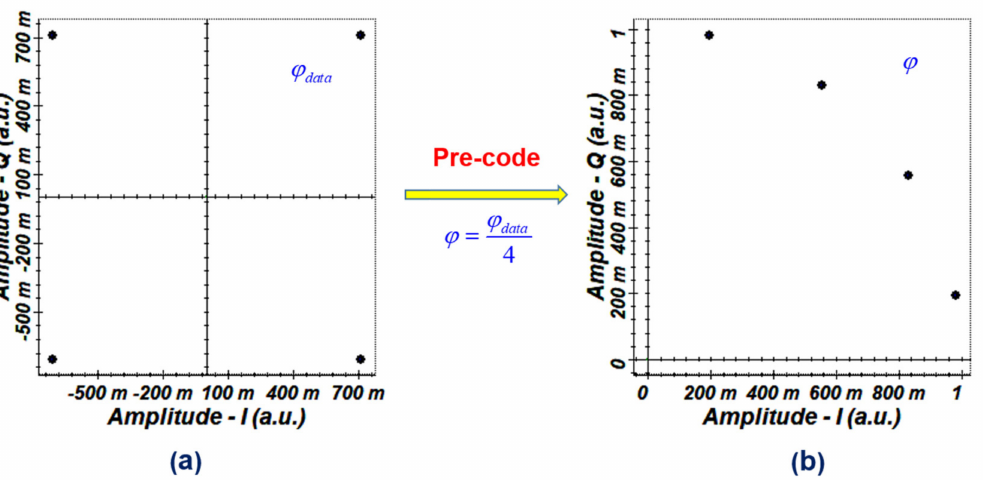
Figure 2. Principle diagram of the precoding QPSK signal. ( a ) Standard QPSK constellation; ( b ) QPSK constellation after